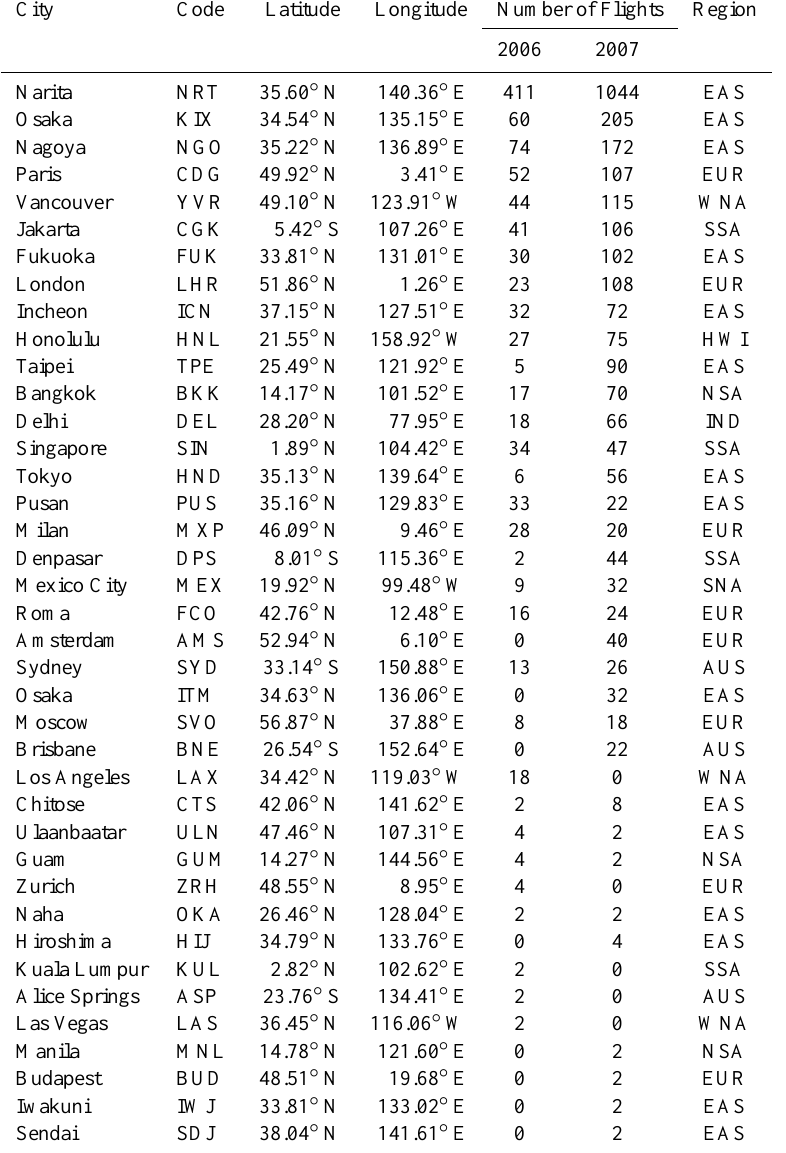
Table 3. List of airports for the CONTRAIL CO 2 measurement, and number of flights at each airport. Latitudes and longitudes are calculated by averaging those of the measurement points during take-offs and